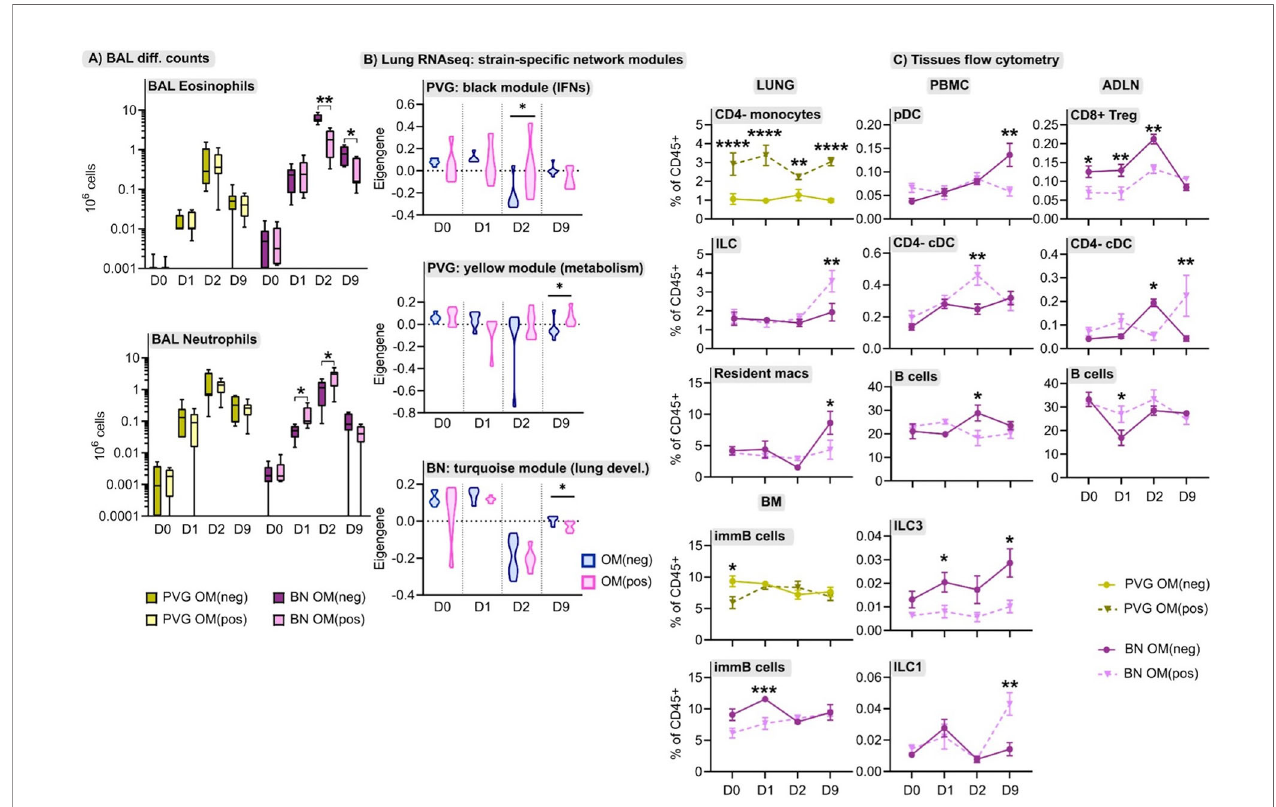
FIGURE 7 | The effect of OM-85 on responses to virus and allergen. (A) Enumeration of eosinophils and neutrophils in BAL via differential cell counts at baseline, and following the course of viral infection and allergen challenge in PVG and BN rats with and without OM-85 pretreatment. Data from more than 3 independent experiments with n = 5-6 per strain, treatment group and time point. (B) The effect of OM-85 pretreatment on gene networks within lung tissue, presented as violin plots of summarized gene expression (eigengene values). Data from more than 3 independent experiments with n = 6 per strain and treatment group. (C) Flow cytometric analysis of lung, PBMC, airway draining lymph node (ADLN) and bone marrow over the course of viral infection and allergen challenge with and without OM-85 treatment. Data are presented as mean ± standard error of the mean, from more than 3 independent experiments with n = 3-7. Statistical comparisons between OM(pos) and OM(neg) samples were performed using one-way ANOVA with Sidak ’ s multiple comparisons tests in (A) and (C) , and Mann-Whitney tests in (B) . *p < 0.05, **p < 0.01, ***p < 0.001, and ****p <